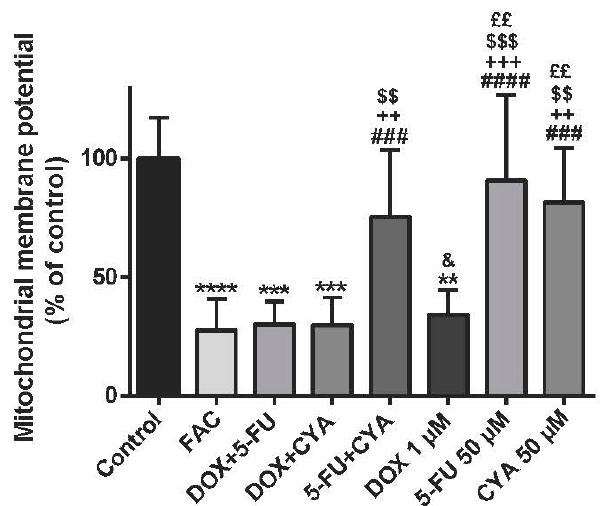
Figure 9. Fluorescence microscopy (Hoechst 33258 staining) of differentiated H9c2 cells after 48 h incubation with FAC, other mixtures of DOX (1 µ M), 5-FU (50 µ M) and CYA (50 µ M) and the drugs alone. Images are representative of two independent experiments (scale bar 100 µ m).